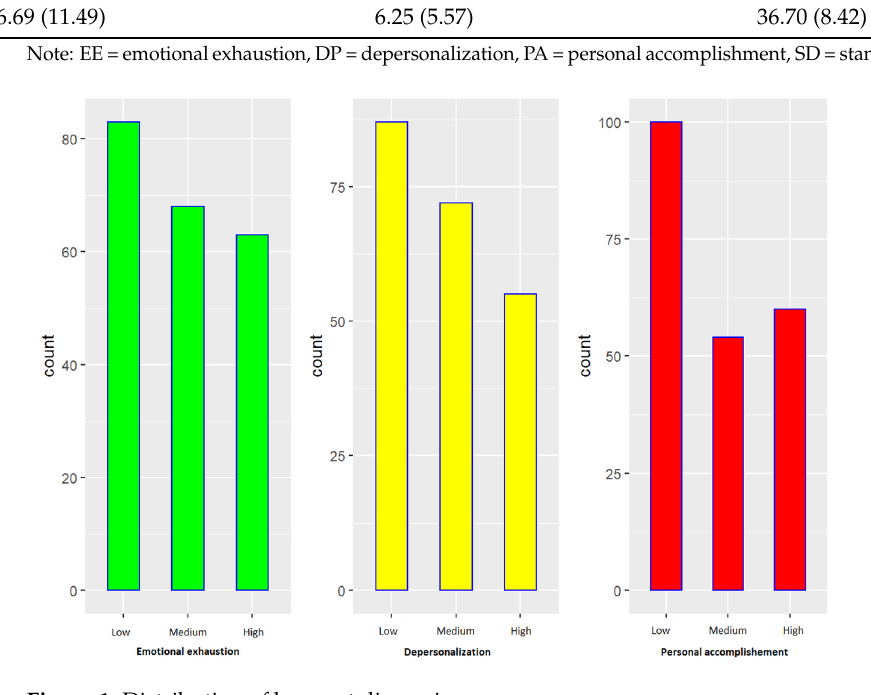
Figure 1. D istribution of burnout dimensions. Figure 1. Distribution of burnout